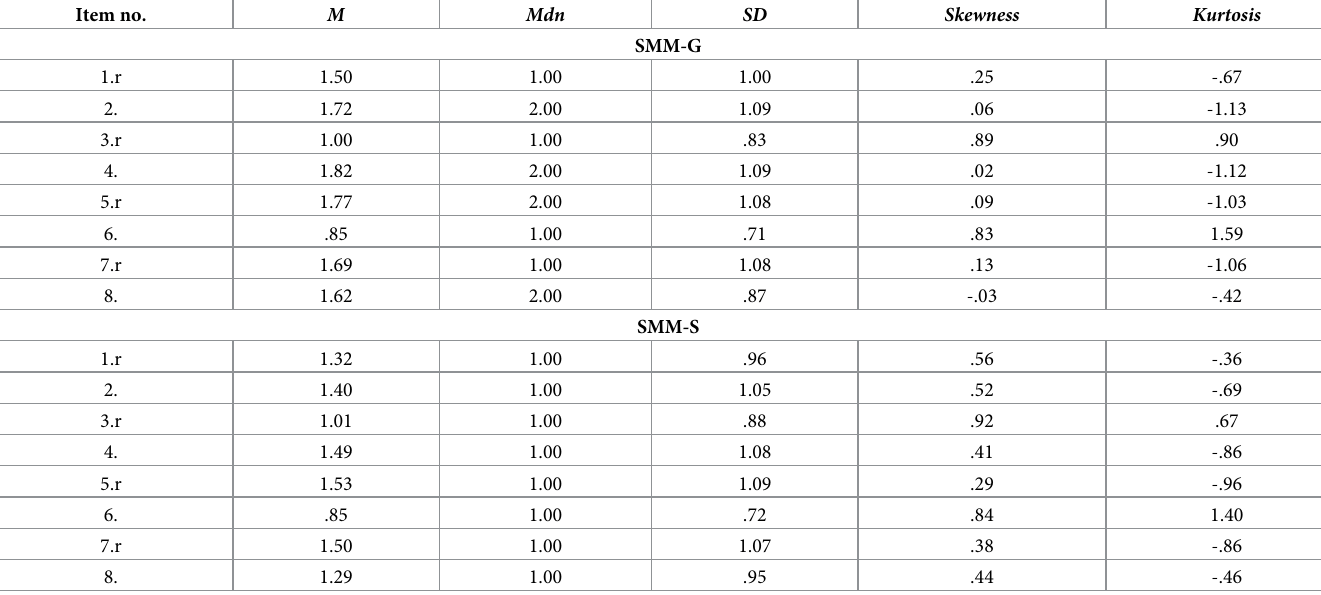
Table 2. Descriptive statistics for items of the Stress Mindset Measure (only Study 1): SMM-G and SMM-S. Item no. M